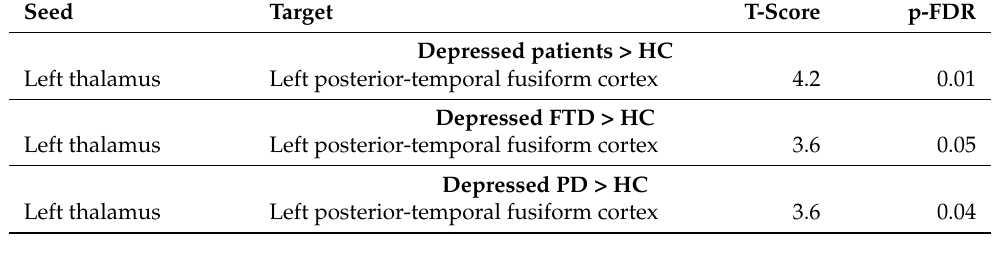
Table 2. Resting-state fMRI seed-to-seed findings between depressed patients and HC group and between depressed FTD and PD patients and HC (higher connectivity between seeds have a positive value of T-score; p-FDR: p -value corrected for false discovery rate).